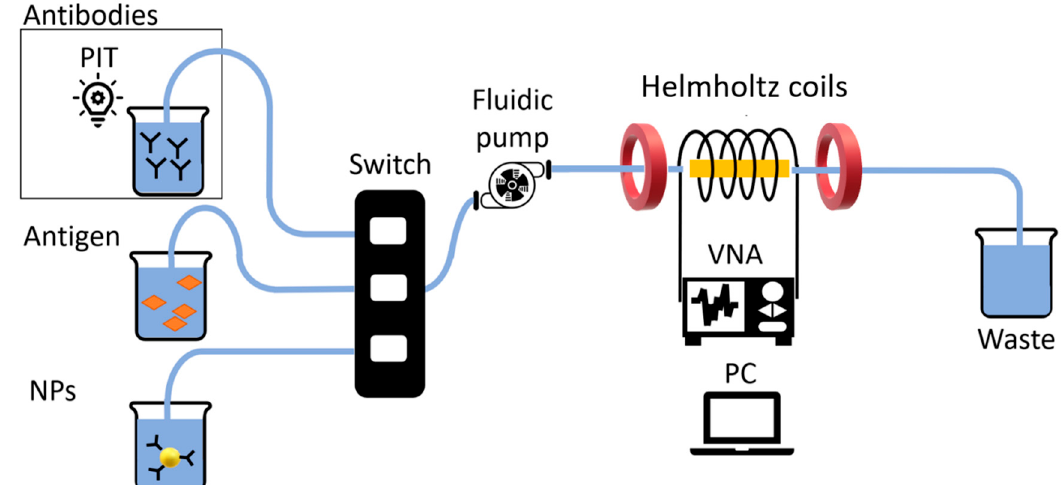
Figure 3. Schematic representation of the experimental setup. From left to right: the solution containing antibodies (activated via PIT), antigens and functionalized nanoparticles, fluidic channels and switch, fluidic (continuous) pump, Helmholtz coils, the ribbon enclosed by the cylindrical coil, the VNA connected to the PC and the flash out container (waste). A flow rate of 5 μ L ∙ s − 1 was used in order to ensure laminar flow over the magnetoelastic sensor. Resonance frequencies were continuously monitored and recorded by the analyzer (VNA) and computer system (PC). Finally, the waste analyte was collected in the flush out container for disposal.